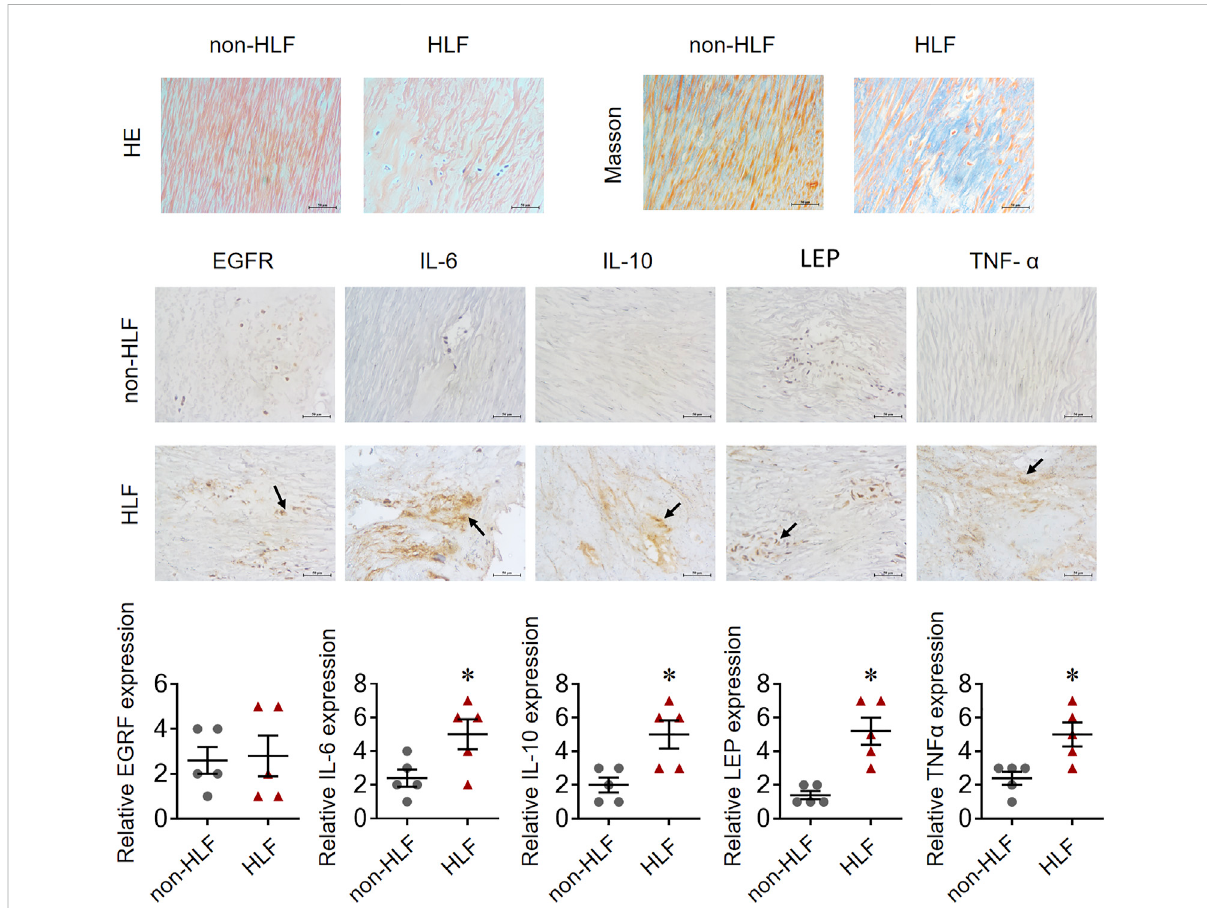
FIGURE 12 EGFR, IL-6, IL-10, LEP, and TNF- α expression in representative LF tissue from LFH ( n = 5)and normal LF group ( n = 5) veri fi ed by IHC.The expression of IL-6, IL-10, LEP, and TNF- α was signi fi cantly higher in the LFH group than in the normal LF group (*, p < 0.05, n = 5) but there was no difference in EGFR